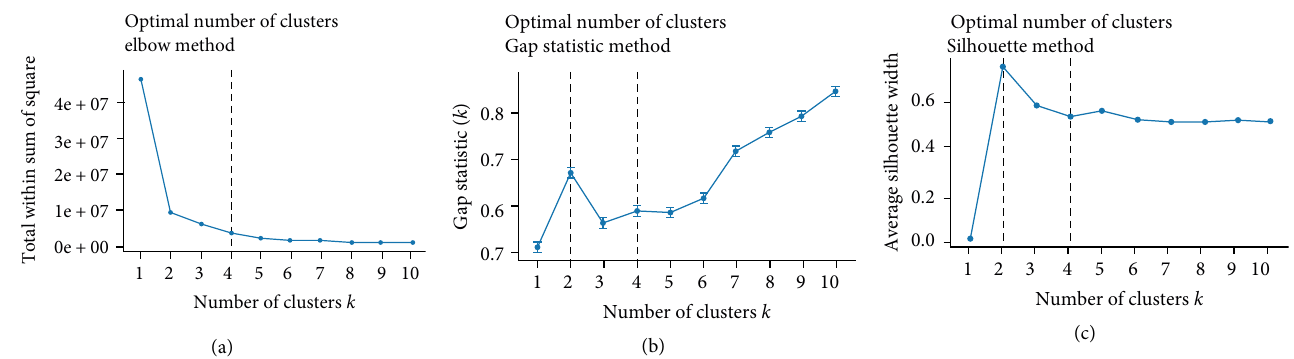
Figure 4: (a) Elbow method; (b) gap statistic method; (c) Silhouette method to achieve the optimal number of clusters.